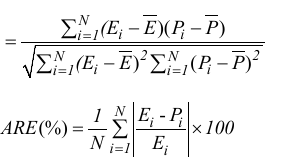
where E is the sample of experimental value, P is the sample of predicted value by ANN model, E and P are the mean value of E and P respectively, N is the number of stress-strain samples. Figure 4a and b shows the correlation relationships of experimental and predicted values for the training procedure and testing procedure, respectively. As shown in Figure 4, the correlation coefficient ( R ) values for the training procedure and testing procedure were calculated to be 0.99998 and 0.99979, respectively. Meanwhile the AARE values for the training procedure and testing procedure were calculated to be determined percent of 0.1190 and 0.2638, respectively. The excellent AARE values and R -values indicate a good correlation between experimental and predicted flow stress values by the ANN model, indicating that the well-trained ANN model has reached the ideal accuracy and is able to predict the flow behaviors of Invar36 alloy well. As the well-trained ANN model has reached excellent accuracy, it can be adopted to predict the flow stress in a wide range of processing parameter. Figure 5 shows the comparison between the datasets predicted by ANN model and the stress-strain curves obtained from compression tests.